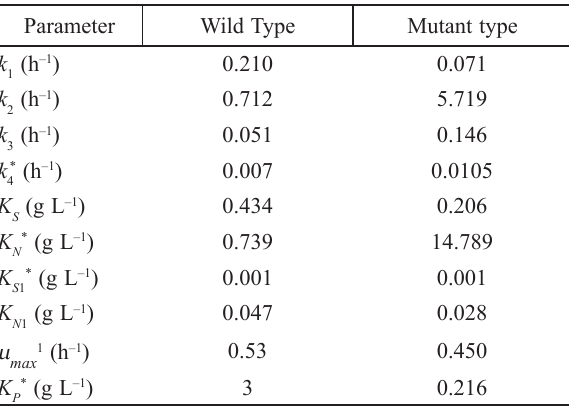
Fig. 3 – Likelihood profiles for parameters of both strains, wild type – black line, and mutant type – gray line Table 1 – Model parameters. These are the best fitting result using the iterative fitting routine 22